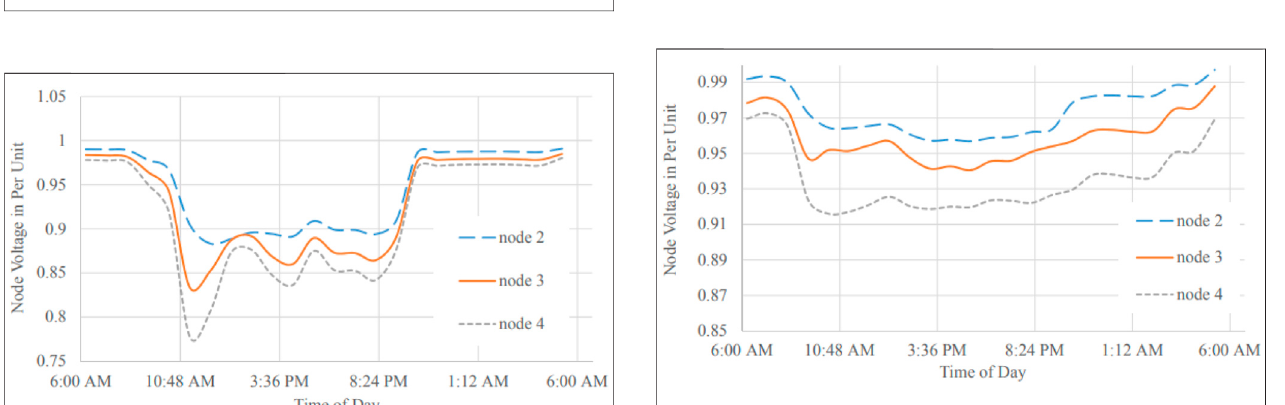
FIGURE 7 | Utility forecast 01 node voltages with reschedule.